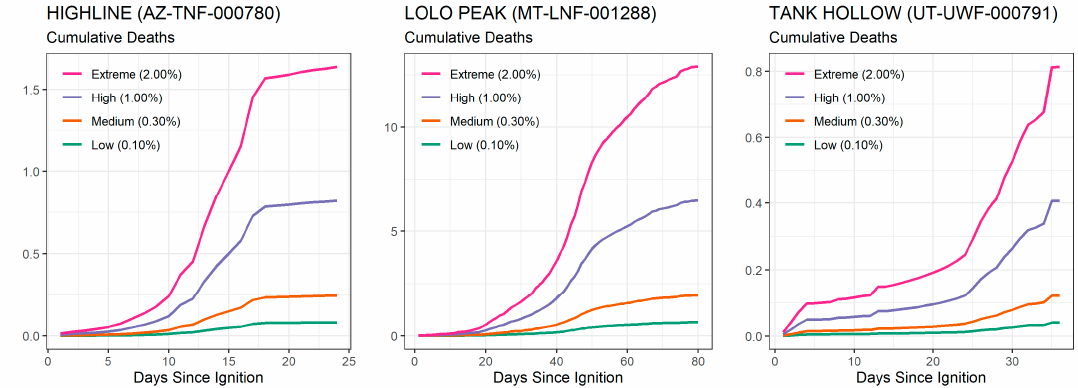
Figure 3. Cumulative deaths over time for the baseline scenario. Note that the vertical axis is not log scaled for this figure.